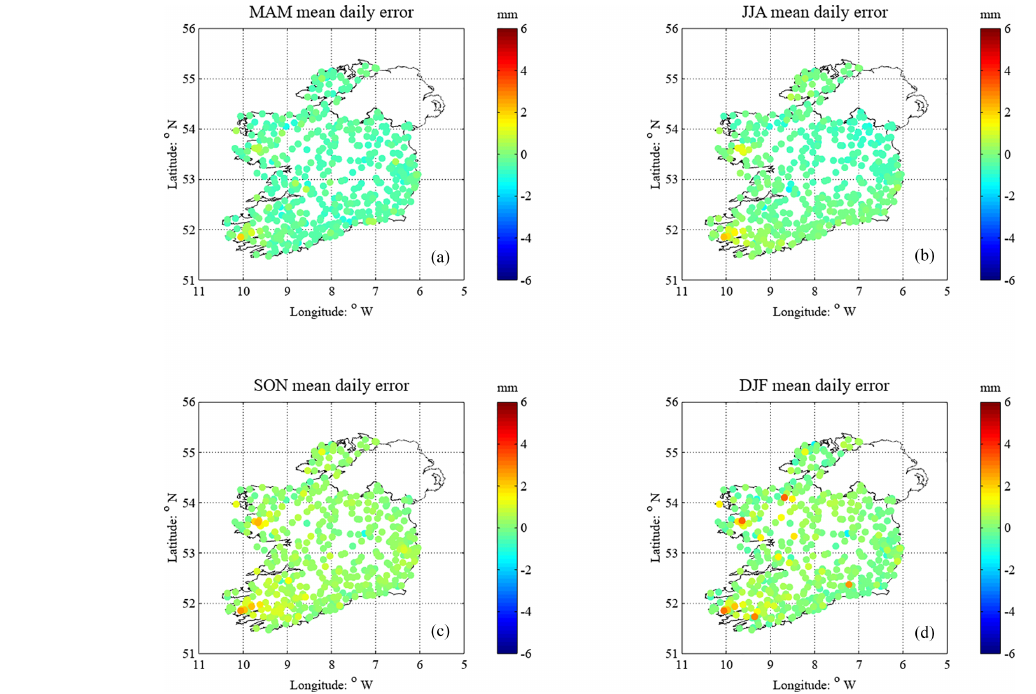
Figure 9. WRF daily precipitation error (by season) for the period 1981–2015, found utilising Met Éireann daily station data for: (a) Spring (MAM); (b) Summer (JJA); (c) Autumn (SON); (d) Winter